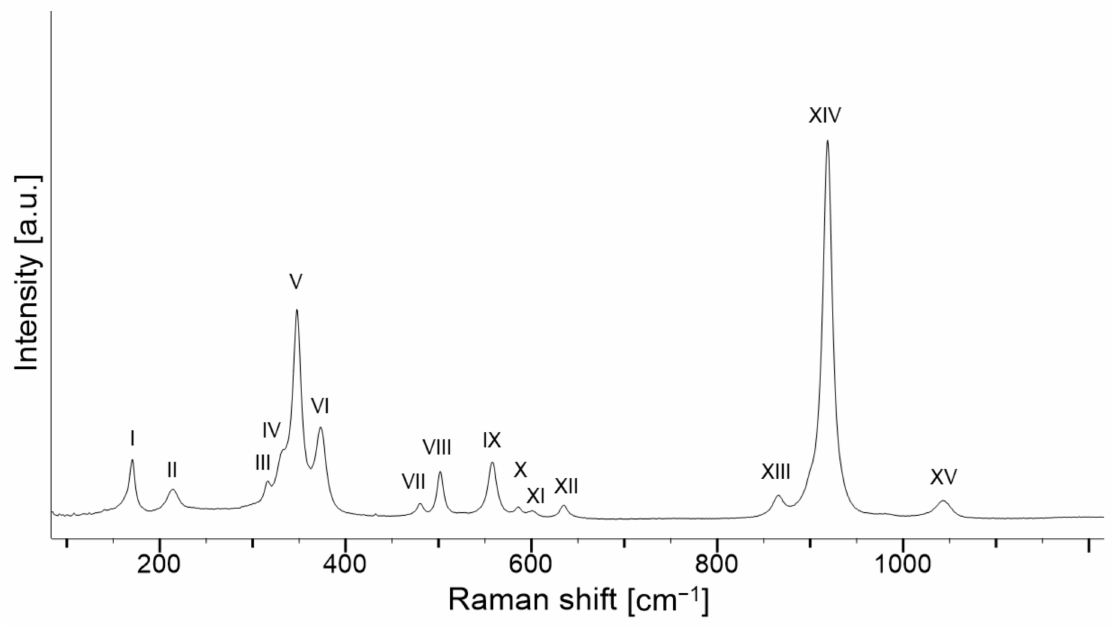
Figure 3. Raman spectrum of almandine garnet (NA247